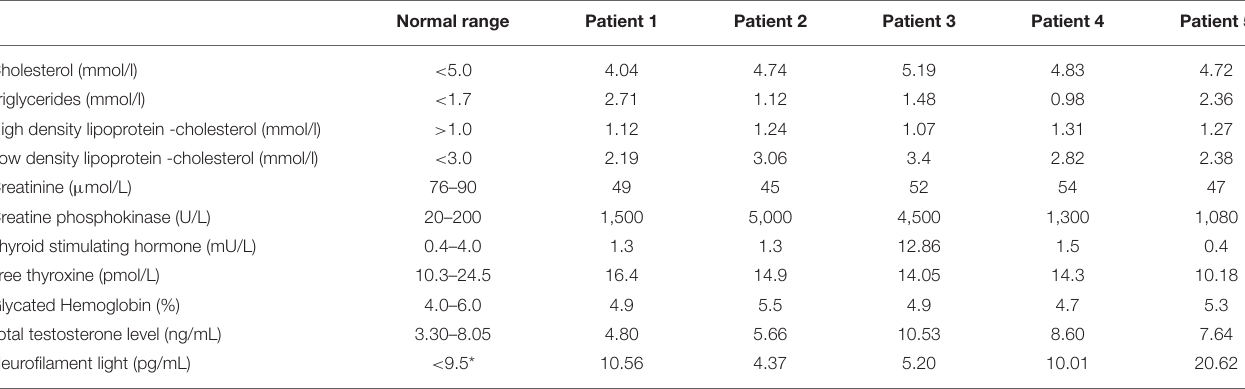
TABLE 5 | Biochemical and hormonal